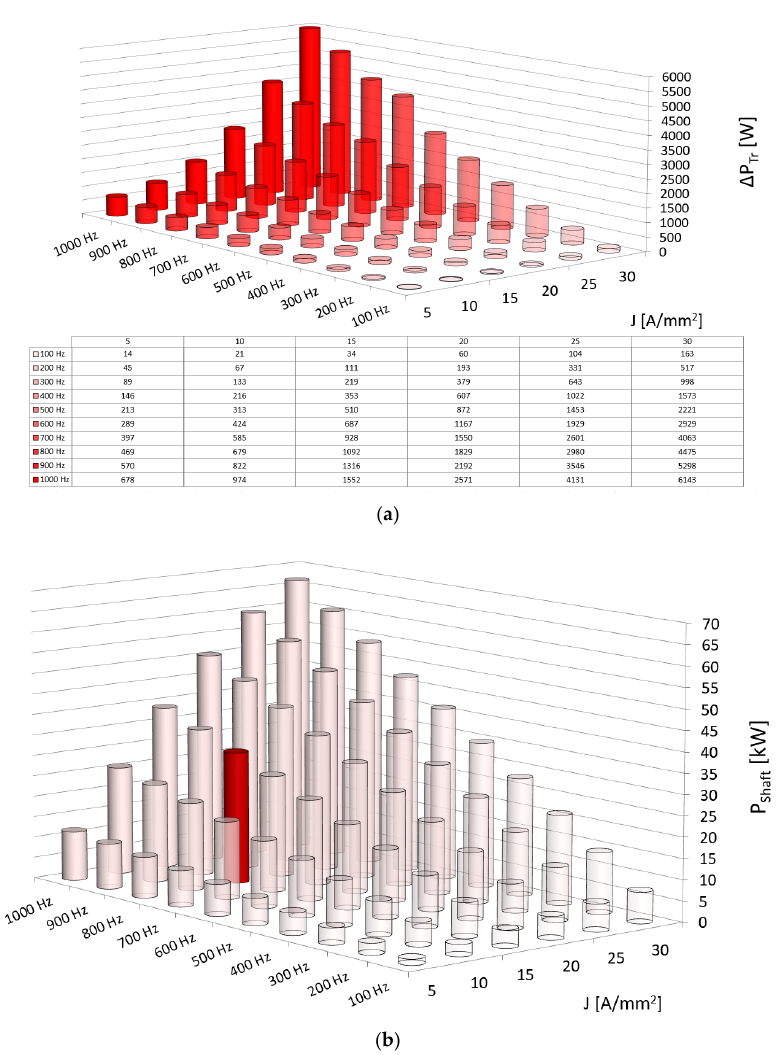
Figure 5. The value of ( a ) total rotor losses Δ P Tr ; ( b ) shaft power as a function of the supply frequency and current density in the winding for solid rotor S355j2.